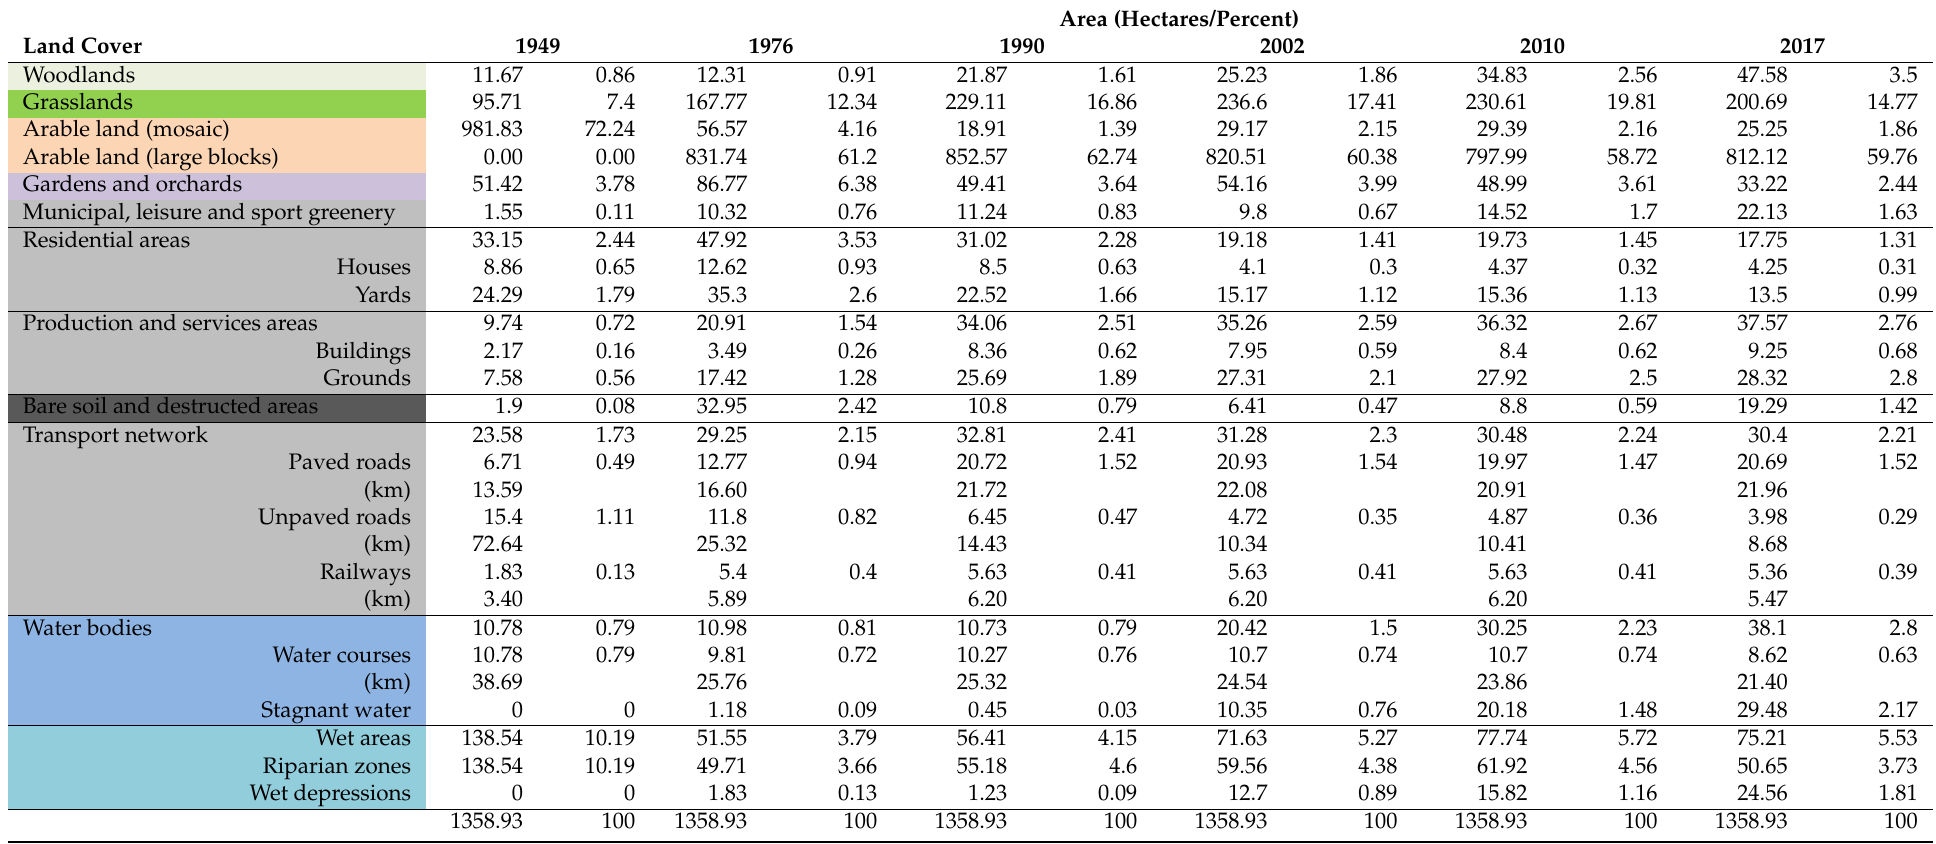
Table 4. Land-cover changes from 1949 to